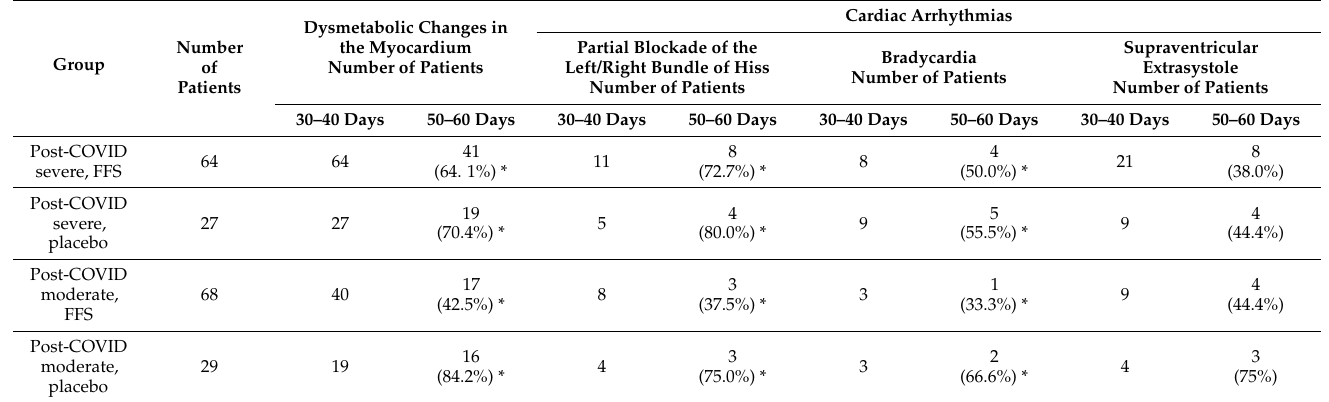
Table 4. Dynamics of electrocardiography (ECG) in post-COVID patients supplemented with FFS or with placebo: number of patients and per cent of patients having a symptom after vs. before the trial